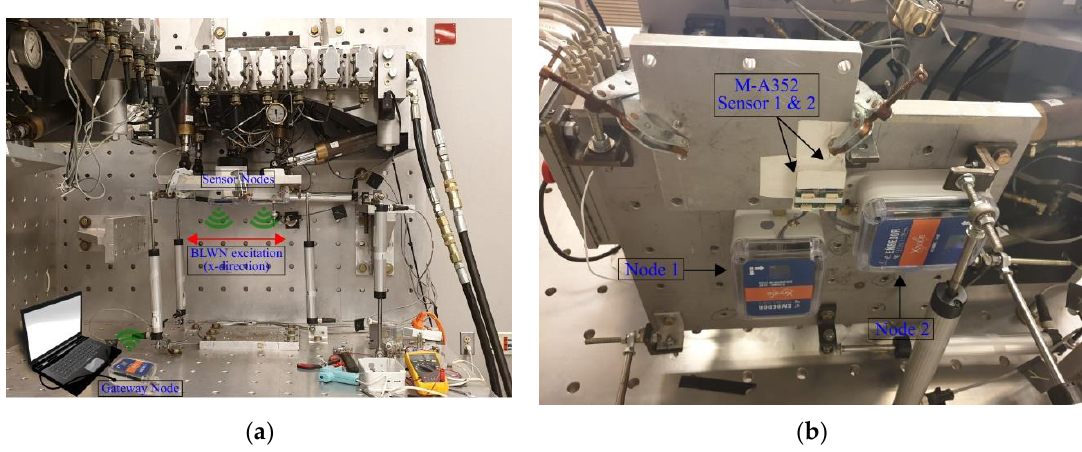
Figure 13. Test-setup for time synchronization error evaluation: ( a ) Load and Boundary Condition Box (LBCB) with test-setup ( b ) Two Xnode sensor nodes with M-A352 mounted to a base plate.